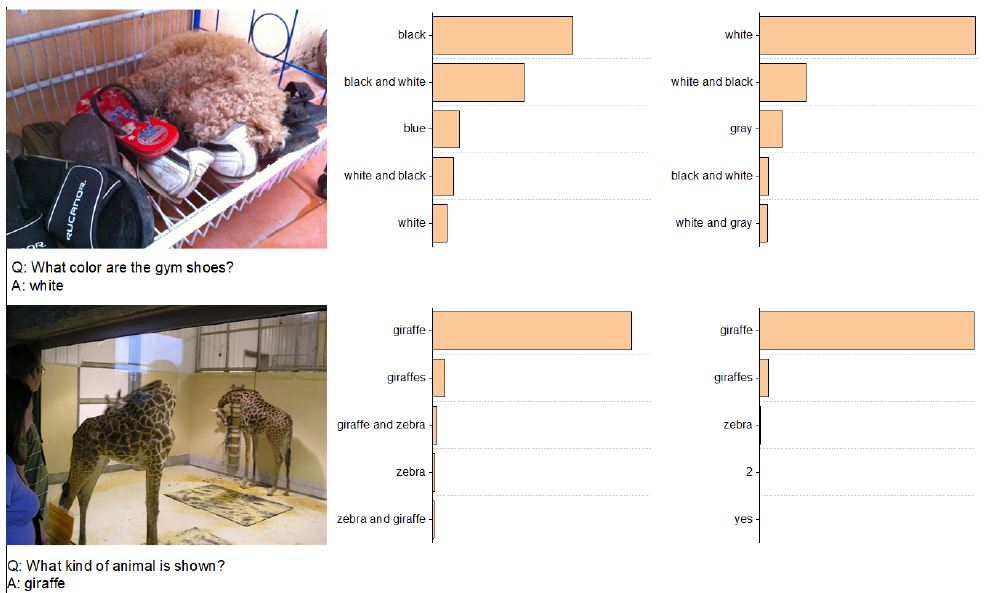
Figure 7. Examples of model prediction. The second column is the TOP5 prediction of the “-PA” model, and the third column is the TOP5 prediction of PAM.